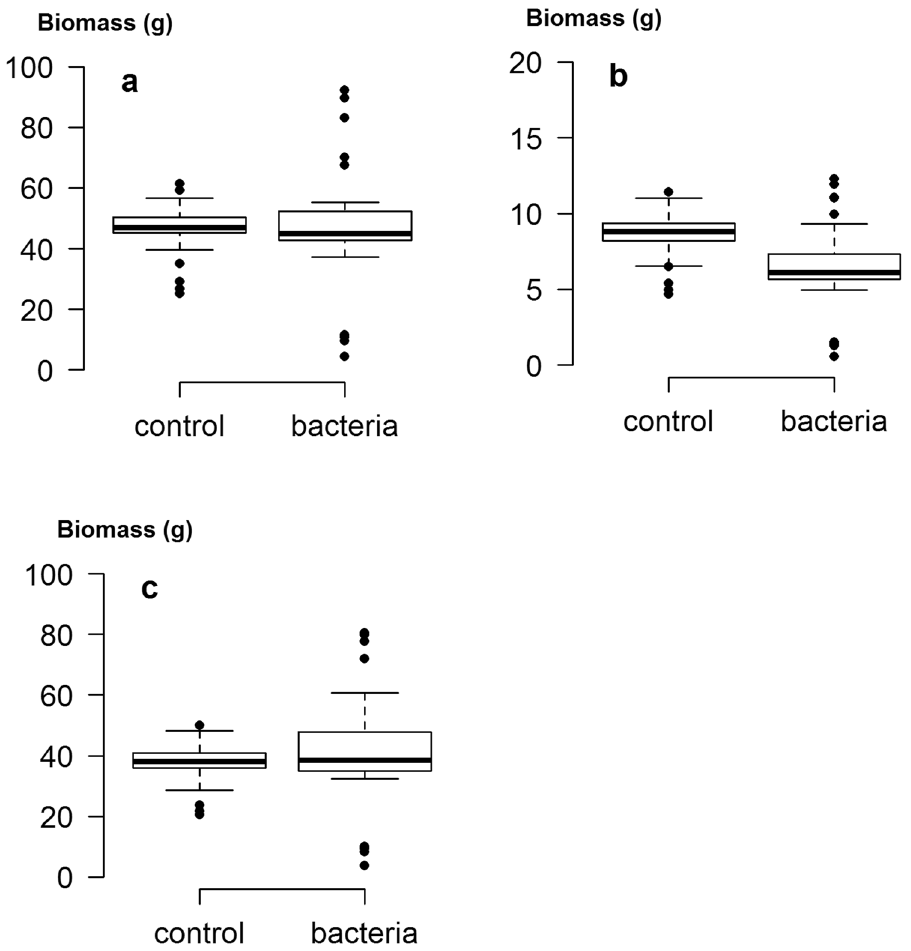
Figure 1. Box plots showing the range in size distributions for ( a ) total biomass, ( b ) root biomass and ( c ) shoot biomass of calabrese plants grown in the controlled experiment, with and without the addition of a mixture of plant growth-promoting rhizobacteria. The horizontal line within the box is the median, while edges of the box represent the inter-quartile ranges. The whiskers depict 1.5x the inter-quartile ranges, while points depict outliers beyond the